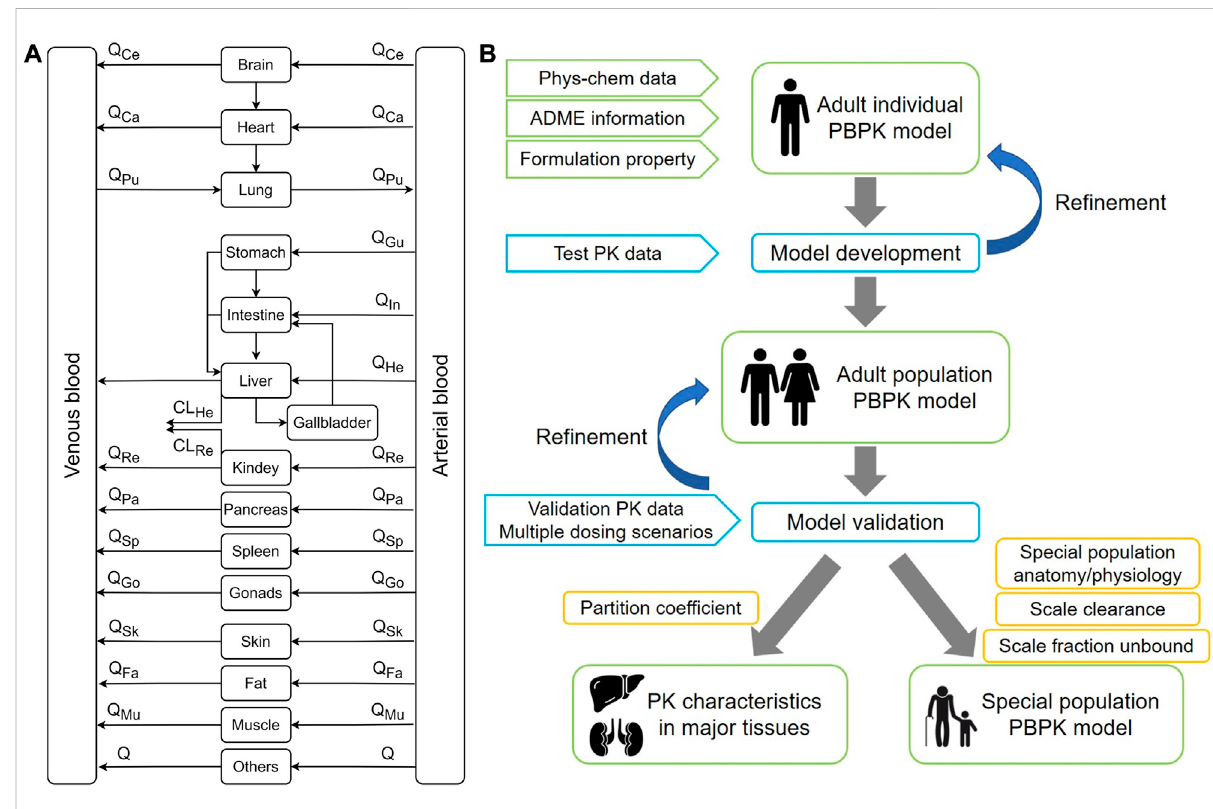
FIGURE 1 The overall design ofthismodeling study. (A) A whole-body physiologically-based pharmacokineticmodel. Q refers to blood fl ow. (B) Diagram for modeling work fl